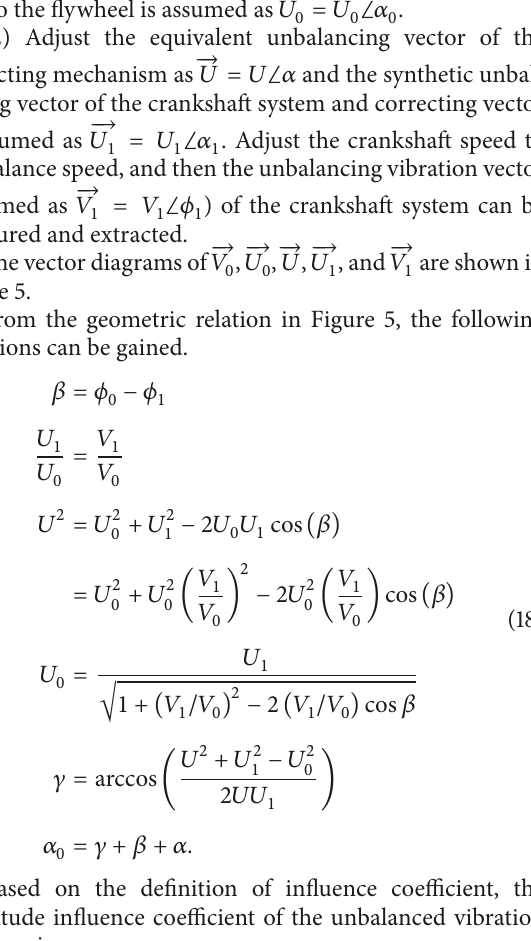
󳨀→ 𝑞 = 1 󳨀→ 𝑞 = 𝑄 ∠270 ∘ , 4 4